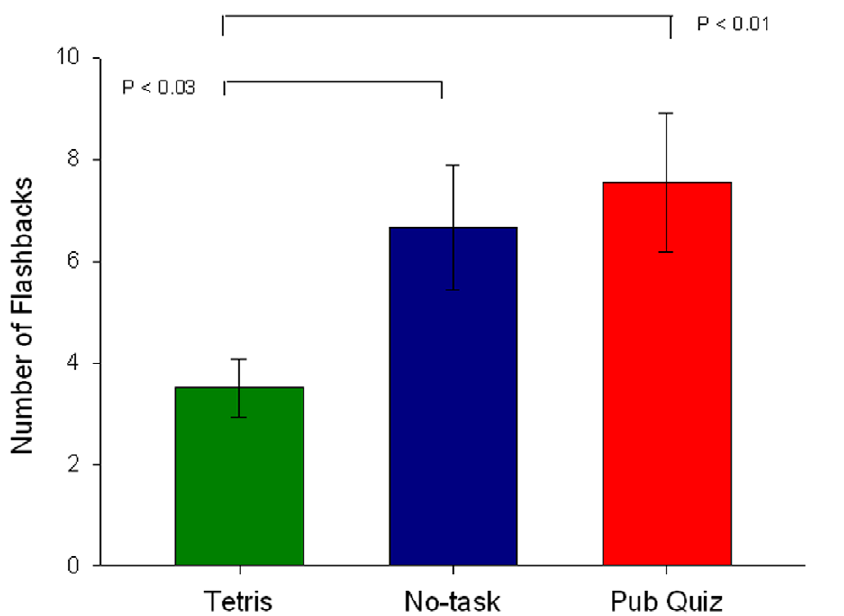
Figure 4. Experiment 2 key outcome variable: flashback frequency in diary over 1-week for the three conditions (mean + / 2 sem).